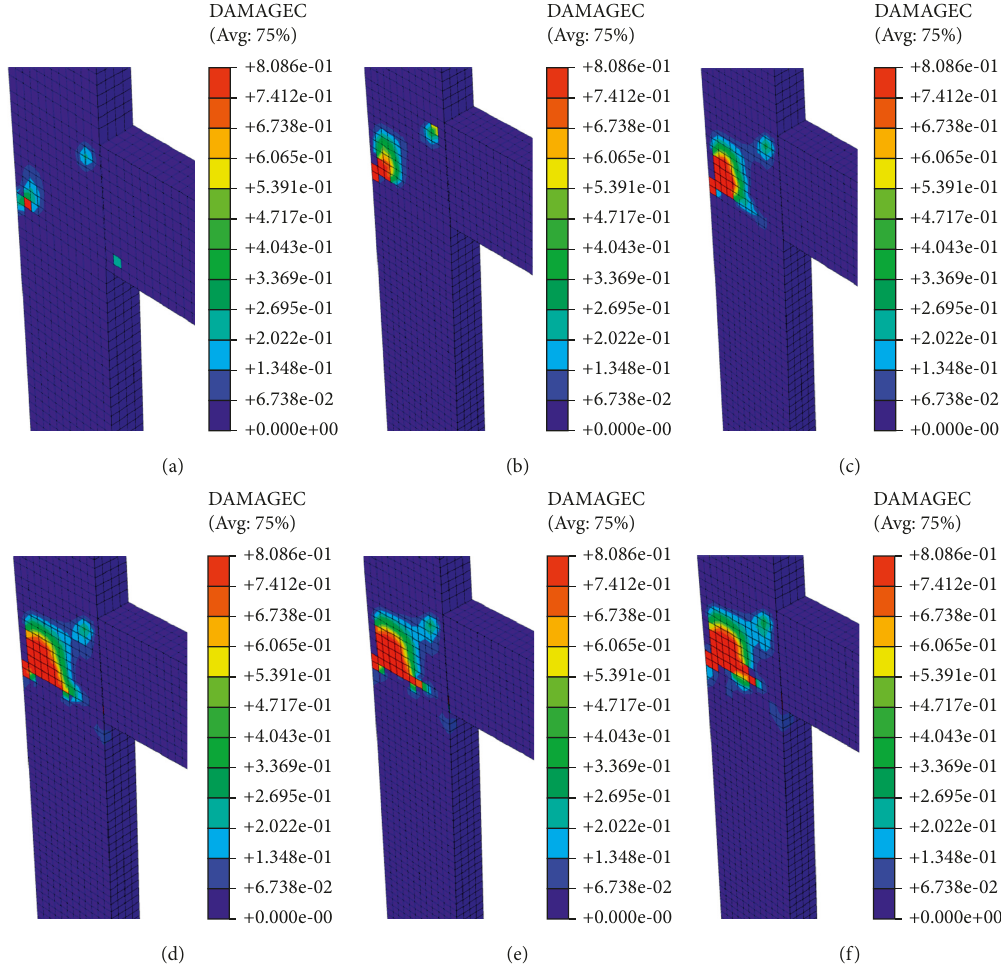
Figure 22: Concrete compression damage for specimens with various reinforcement ratios: (a) G3M1, 0.9%; (b) G3M2, 1.2%; (c) Ref- erential, 1.6%; (d) G3M3, 2.4%; (e) G3M4, 3%; and (f) G3M5,